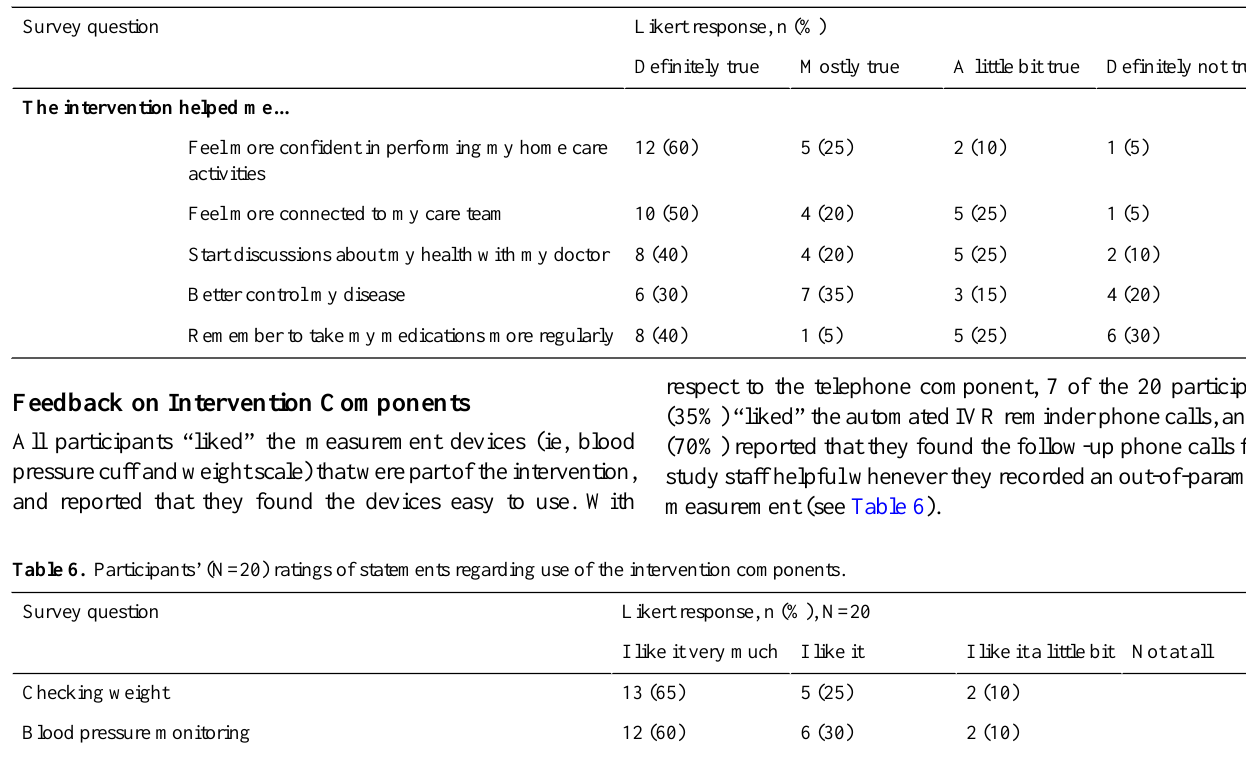
Definitely not trueA little bit trueMostly trueDefinitely true